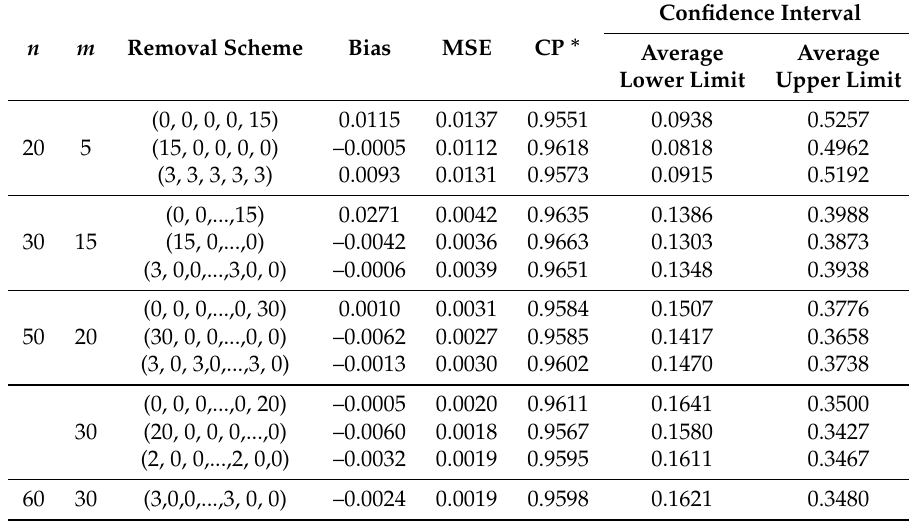
Estimation results of δ s , k using the parametric percentile bootstrap method for